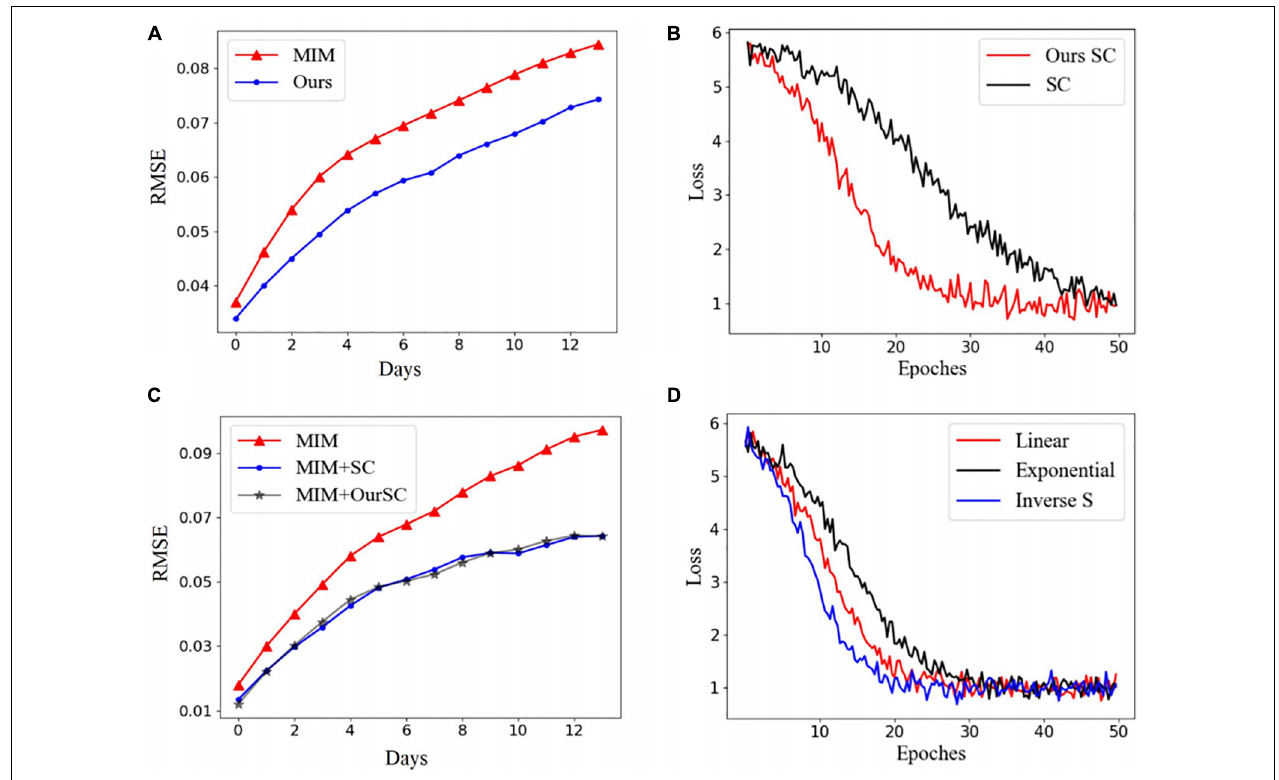
FIGURE 6 | Prediction performance evaluation in enhanced MIM model with scheduled sampling (SC). (A) 14-day prediction performance comparison between original MIM and our enhanced scheme. (B) Comparison between our improved scheduled sampling (SC) with the classical one. (C) The enhanced MIM combining with the different scheduled sampling (SC) strategies. (D) Comparison in weight adjustment means.